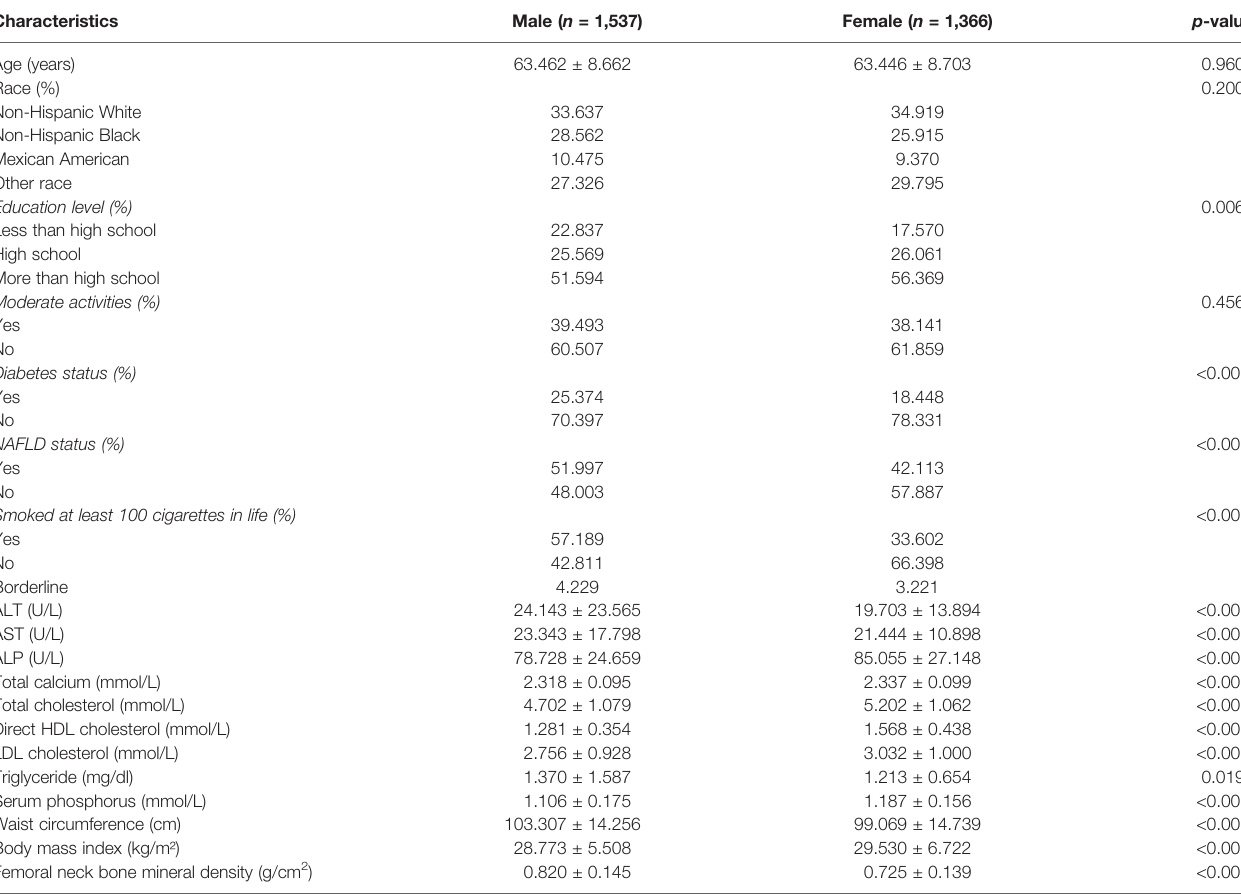
TABLE 1 | Characteristics of the participants.